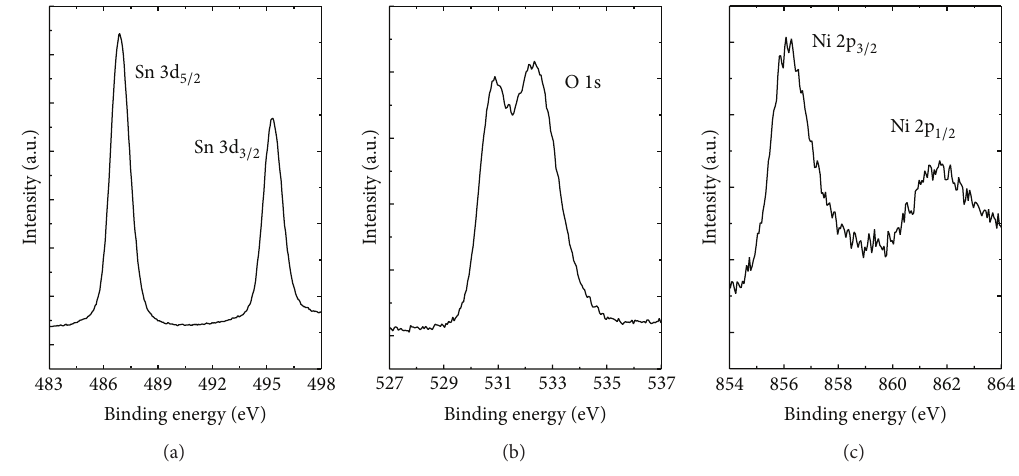
Figure 5: High-resolution spectrum of (a) Sn 3d, (b) O 1s, and (c) Ni 2p